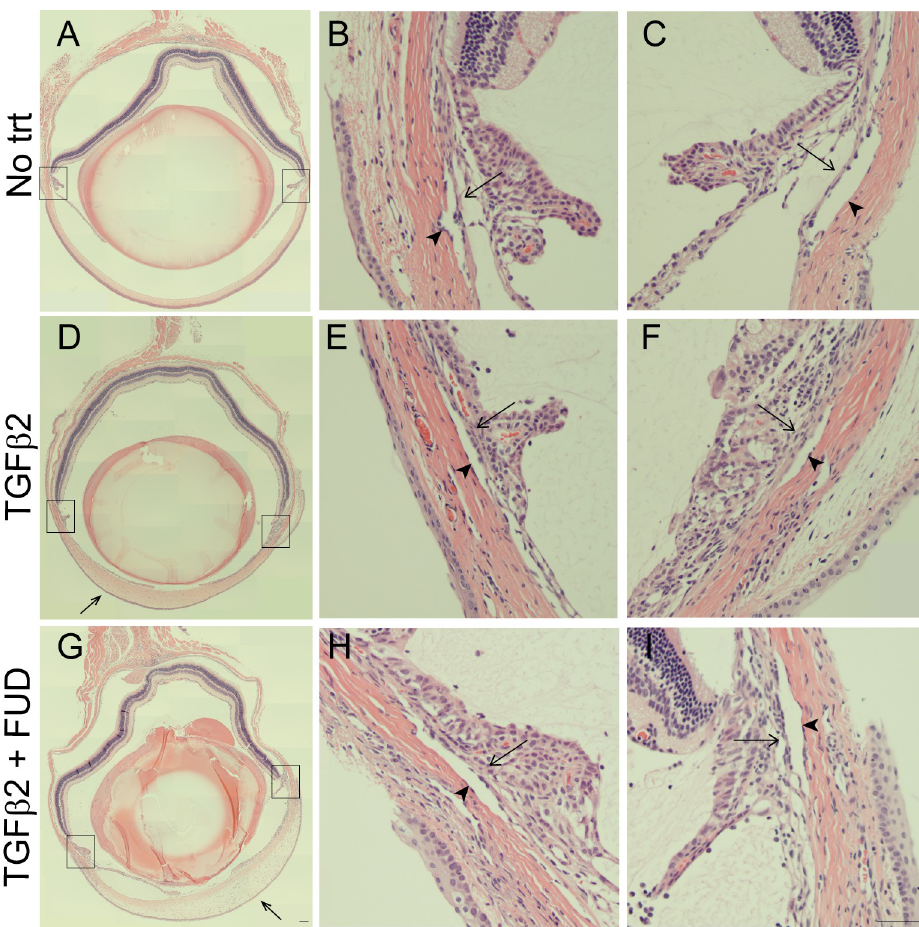
Fig 4. TGF β 2 and FUD treatment affected mouse eye morphology. Hematoxylin and eosin staining of an uninjected (No trt) mouse eye (A), a mouse eye 22 days after an intravitreal injection of Ad5- TGF β 2 viral vector (D) and a mouse eye 22 days after an intravitreal injection of Ad5-TGF β 2 vector with an intracameral FUD injection on Day 15 (G). Higher magnifications of the trabecular meshwork and Schlemm’s Canal of the control eye (B, C), TGF β 2 treated eye (E, F) and TGF β 2 + FUD treated eye (H, I). Micrographs are representative. Boxes in A, D and G are the TM shown in higher magnification in B, C, E, F, H and I. Closed arrows indicate corneal edema, open arrows indicate the TM and arrowheads indicate Schlemm’s Canal. Bar (G) = 100 μ m, bar (I) = 50 μ